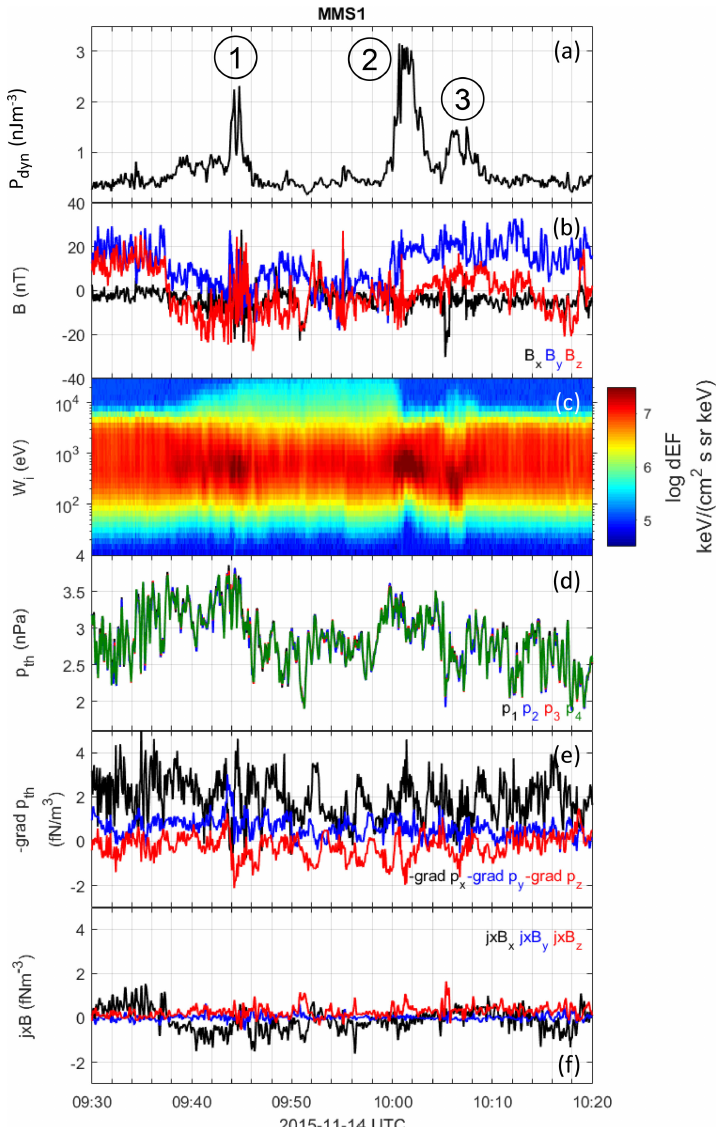
Figure 9. Forces on the jet plasma. From top to bottom: dynamic pressure, magnetic field, ion spectrogram, total thermal pressure for satellites 1–4, negative of the gradient of the total pressure, and the magnetic force j × B